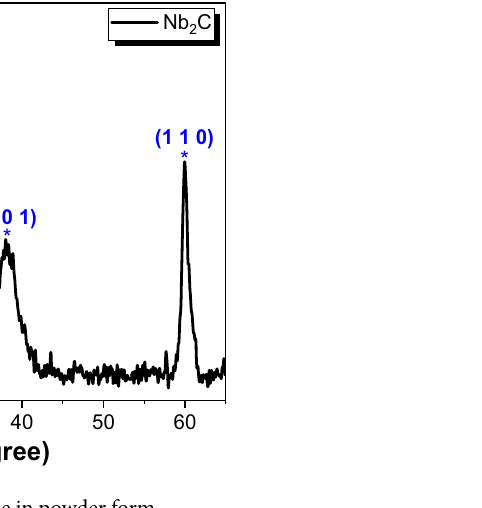
Figure 1. XRD pattern for Nb 2 C MXene in powder